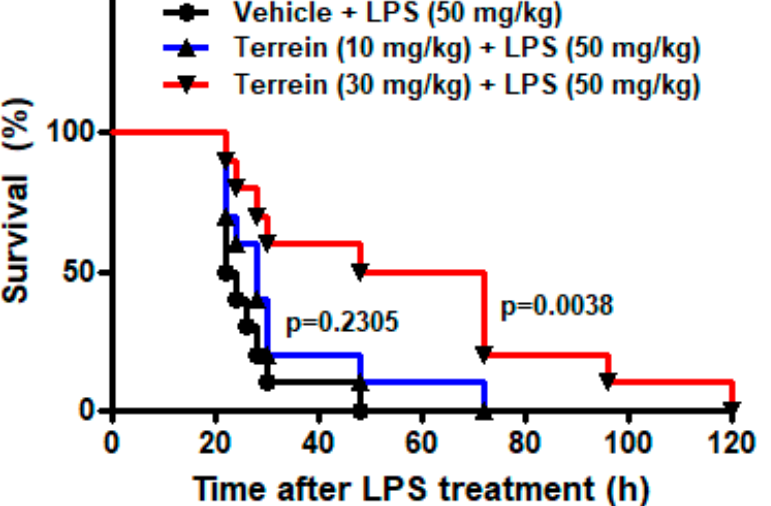
Figure 2. Effect of terrein on survival of mice in LPS − induced endotoxemia model. Different groups ( n = 10) of animals were treated with vehicle or indicated concentrations of terrein 2 h before LPS (50 mg/kg) treatment. The survival rate was monitored until 120 h.